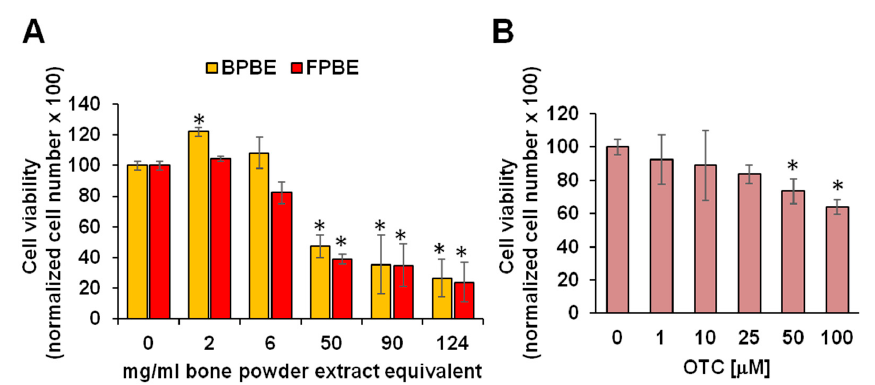
Figure 1. Effect of bone powder extracts on K562 cell viability. Cells were incubated for 24 h with the indicated concentrations of either biologically raised poultry bone extract (BPBE) and intensive-farming raised poultry bone extract (FPBE) ( A ) or oxytetracycline (OTC) ( B ) and directly counted by the Trypan Blue exclusion test. Bars are means ± SEM of four independent biological replicates for each condition and are percentages of vehicle-treated cells; * p < 0.05 vs. 0 g/ml of bone extracts or 0 mM OTC.